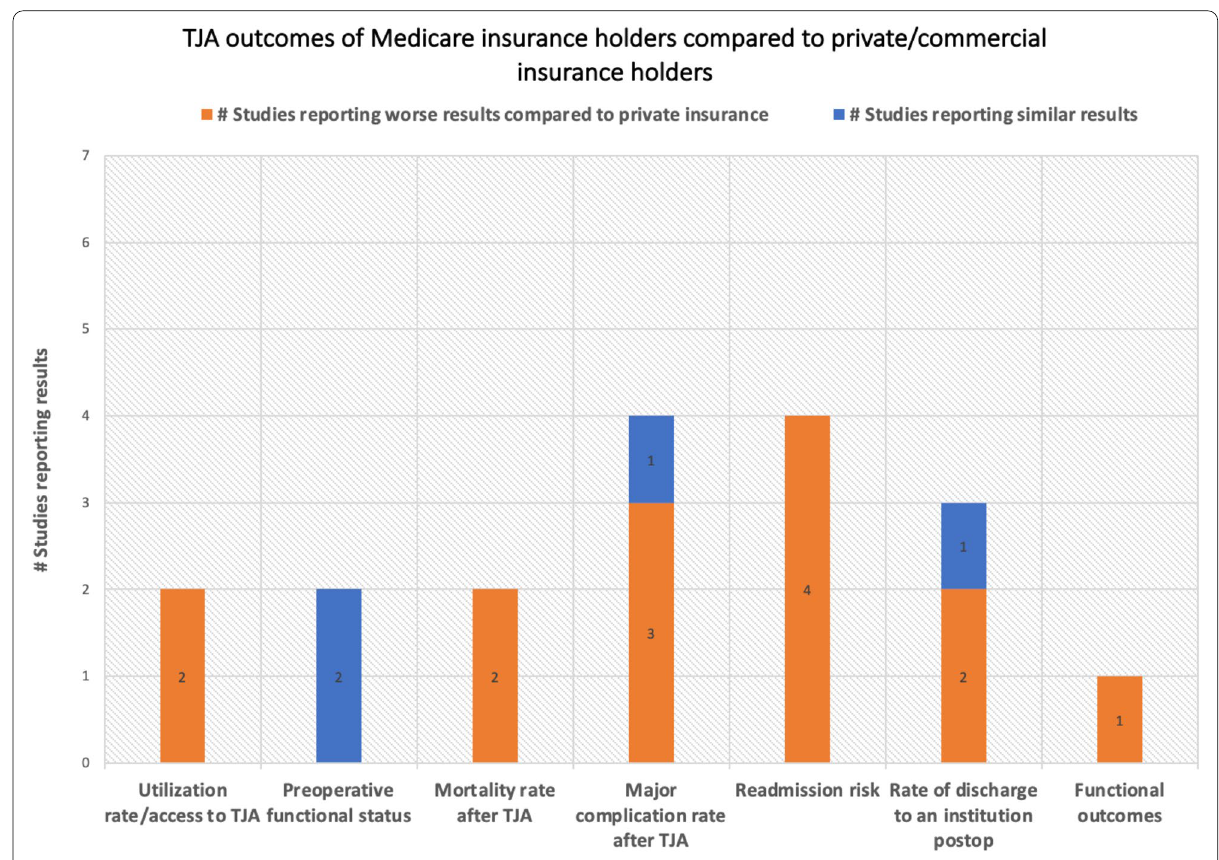
Fig. 3 TJA outcomes of Medicare compared to private/commercial insurance